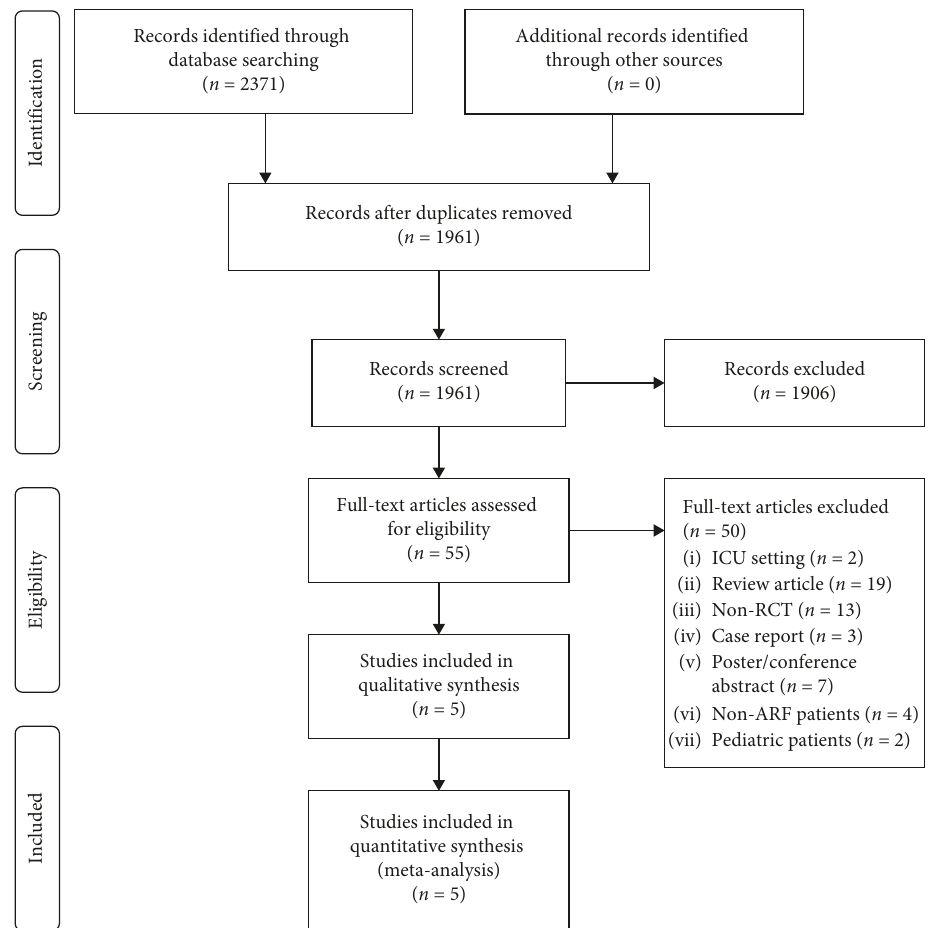
Figure 1: PRISMA flow diagram.